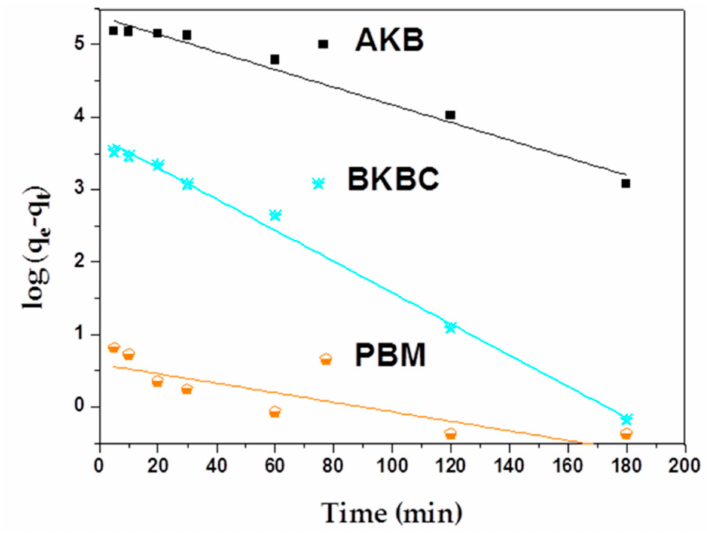
Figure 7. Pseudo-first order kinetics plots for adsorption of AKB, BKBC, and PBM.